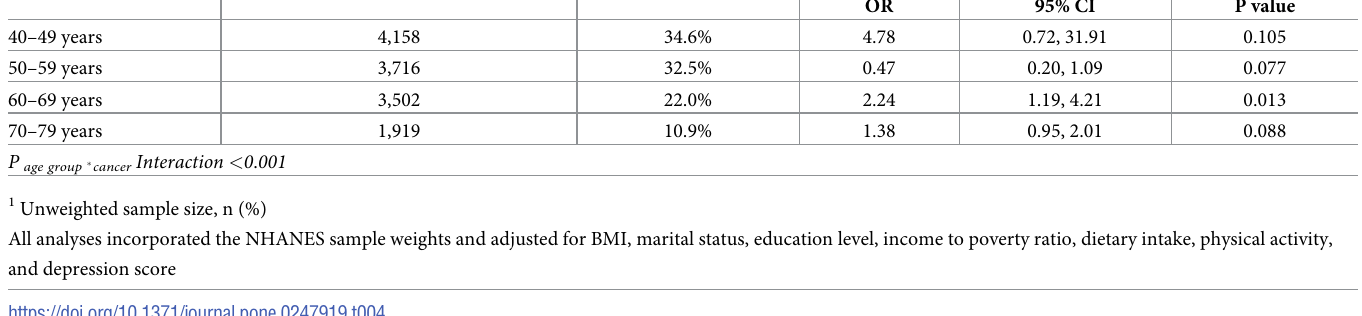
having elevated 10-year ASCVD risk. The association between cancer status and elevated 10-year ASCVD risk based on Pooled Cohort Equations did not change, and the interaction between age and cancer status in relation to odds of elevated 10-year ASCVD risk remained (S2 Table in S1 File). Compared to the observed association in terms of specific cancer types in the main analysis, we did not observe the higher odds of elevated 10-year ASCVD risk in lung cancer (OR = 2.59, 95% CI: 0.98–6.88), but observed lower odds of elevated 10-year ASCVD risk in thyroid cancer (OR = 0.11, 95% CI: 0.01–0.86) in the model including individuals with a CVD history (S3 Table in S1 File).